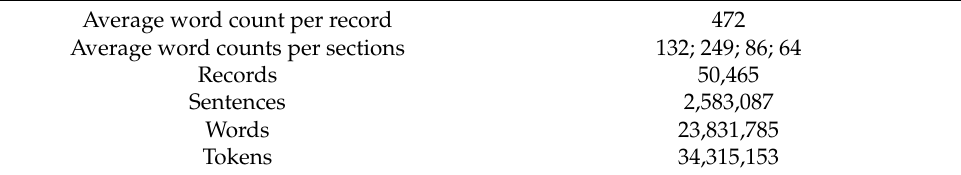
Table 1. Statistics detailing unit counts and averages in the Polish health record